Question: Judging by this figure, is the value going up or going down?
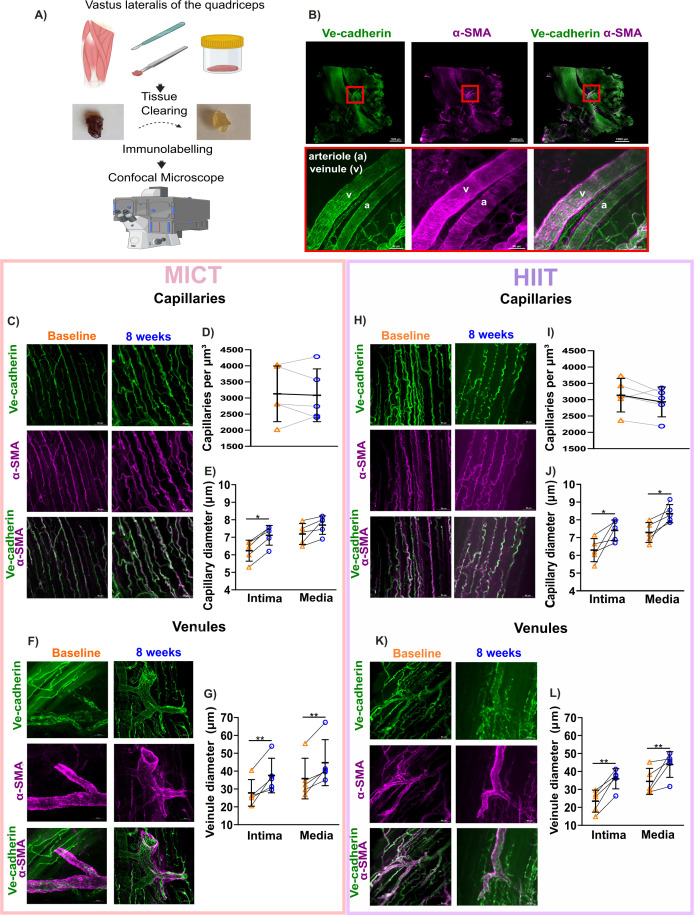
Answer: increasing